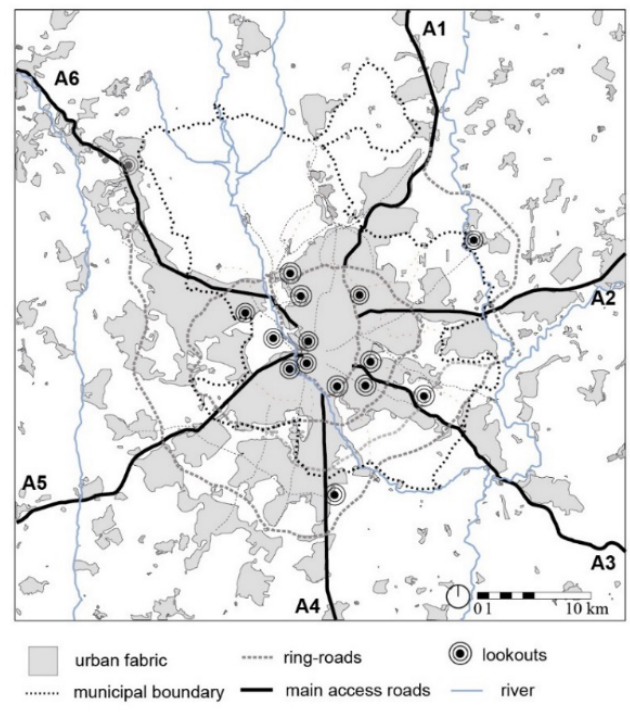
Figure 3: Metropolitan area of Madrid, showing the selection of lookouts and roads